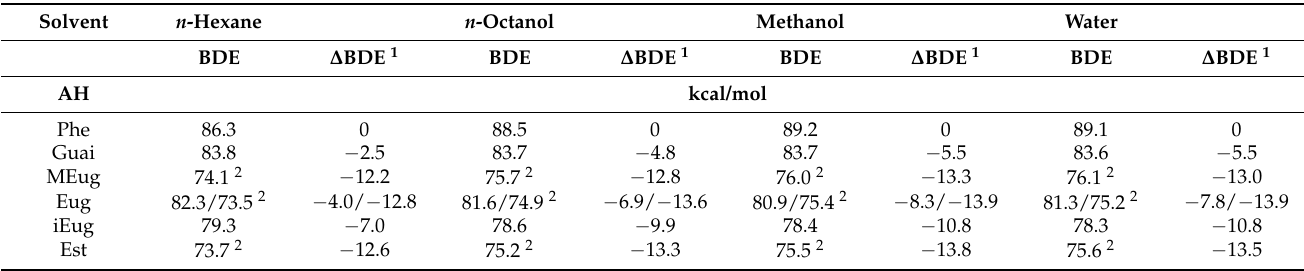
Table 2. Absolute and relative ( ∆ ) BDE values (kcal/mol) of the test compounds with labile -O-H and/or C-H bonds computed in n -hexane, n -octanol, methanol, and water at B3LYP/6-31G//B3LYP/6-311++(2d,2p) level. Solvent